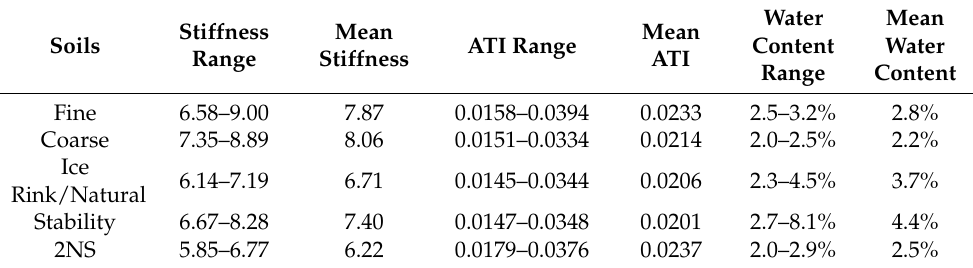
Table 3. Table of stiffness (MN/m) and ATI ranges and means for each soil. ATI values are taken after 3 h of heating.